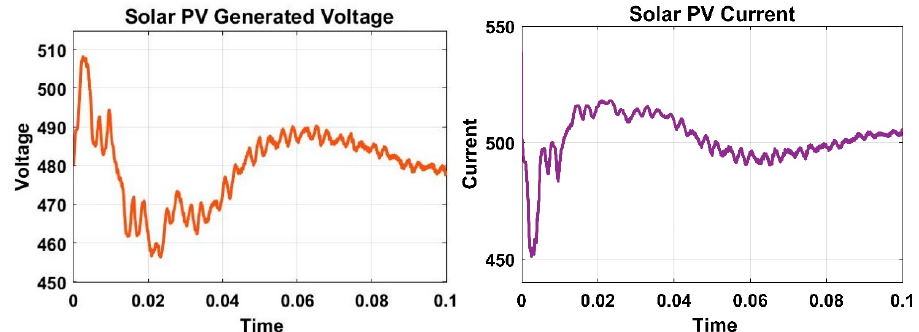
Figure 5. Generated voltage and current of solar photovoltaic (PV) system.